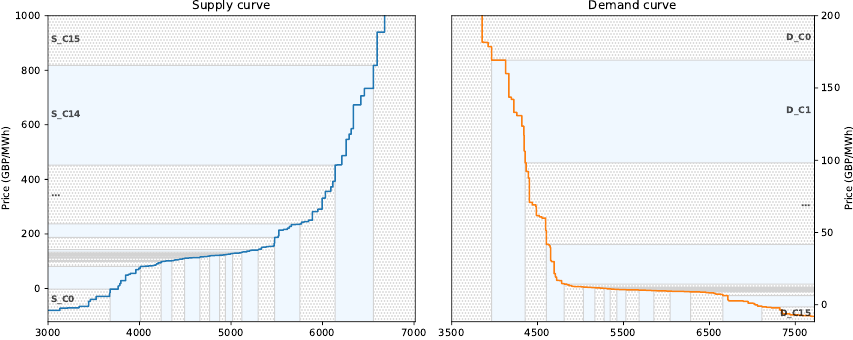
Figure 2. Illustration of price classes for the supply ( left ) and demand curves ( right ). The volume of bids in each price band is aggregated for all hours in the dataset to create an individual time series for each price band, which is then forecasted using a linear regression model. Once the forecast for each individual class has been produced, the supply and demand curves are reconstructed, and their intersection and, hence, the clearing price can be